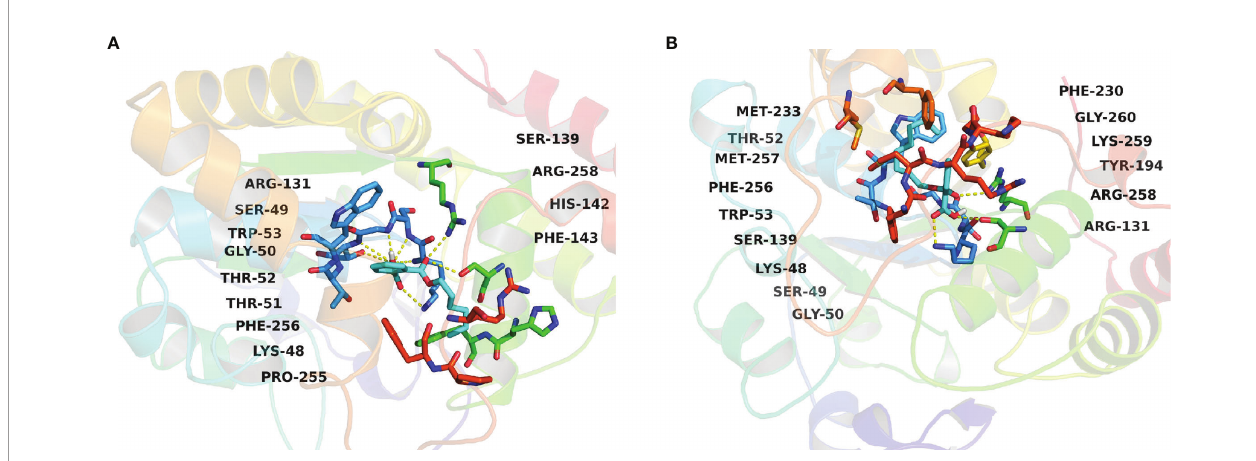
FIGURE 5 | Active pocket of SULT1B1 binding with MHP (A) and MOP (B) .